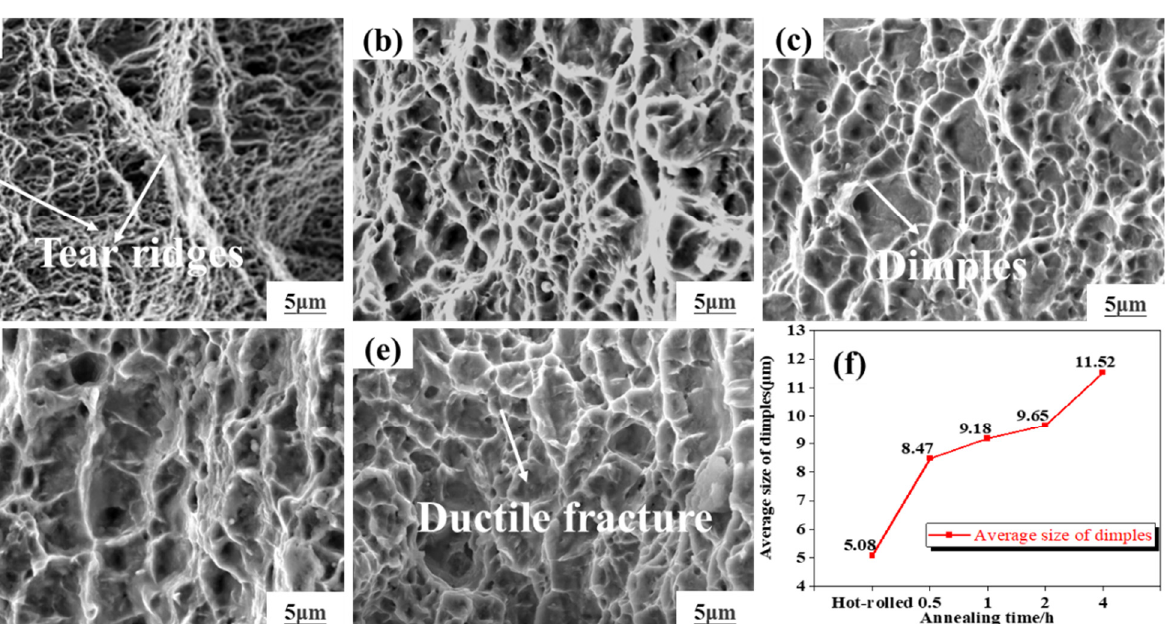
Figure 10. Vickers hardness of TA10 alloy.